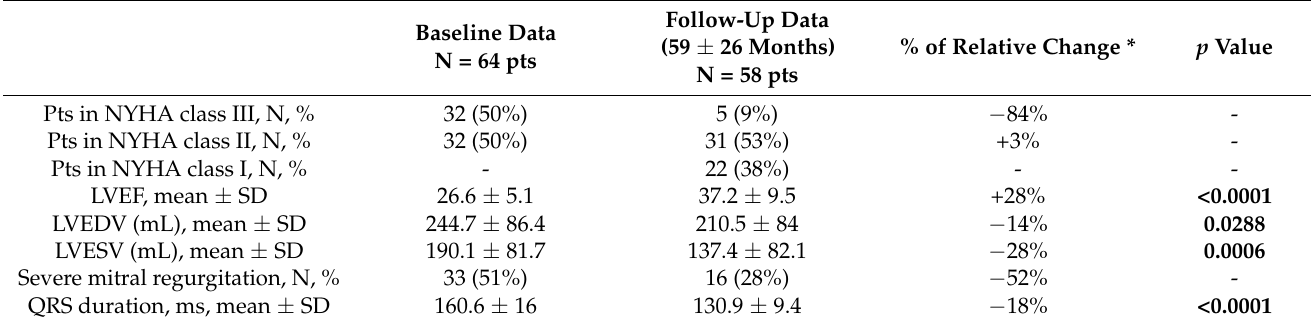
Table 3. Comparative data regarding the main clinical and echocardiographical parameters at baseline versus follow-up.